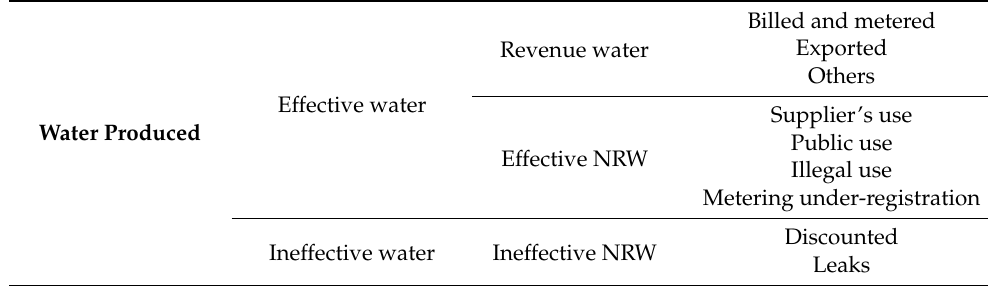
Table 1. Components of Water Balance. Non-revenue water